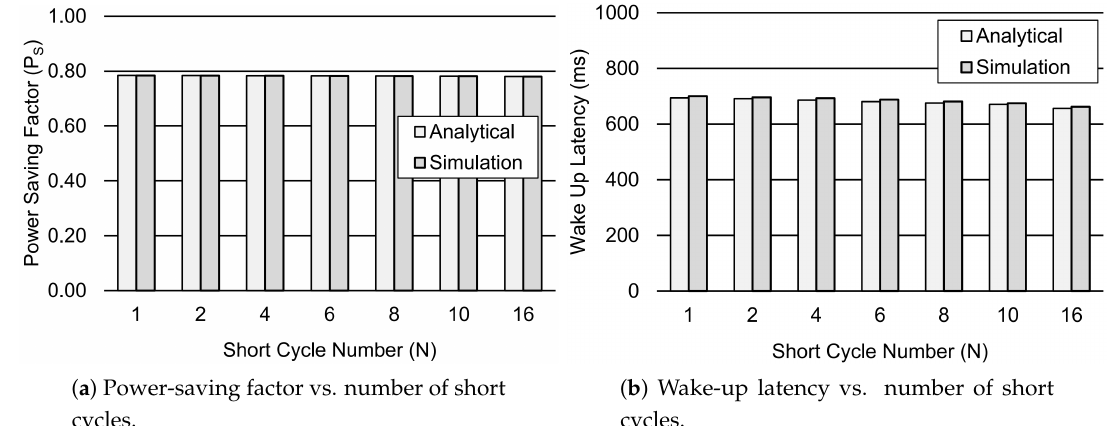
Figure 10. Performance analysis of the DRX mechanism for a different number of N . Other parameter settings include 1 T tail = 11.576